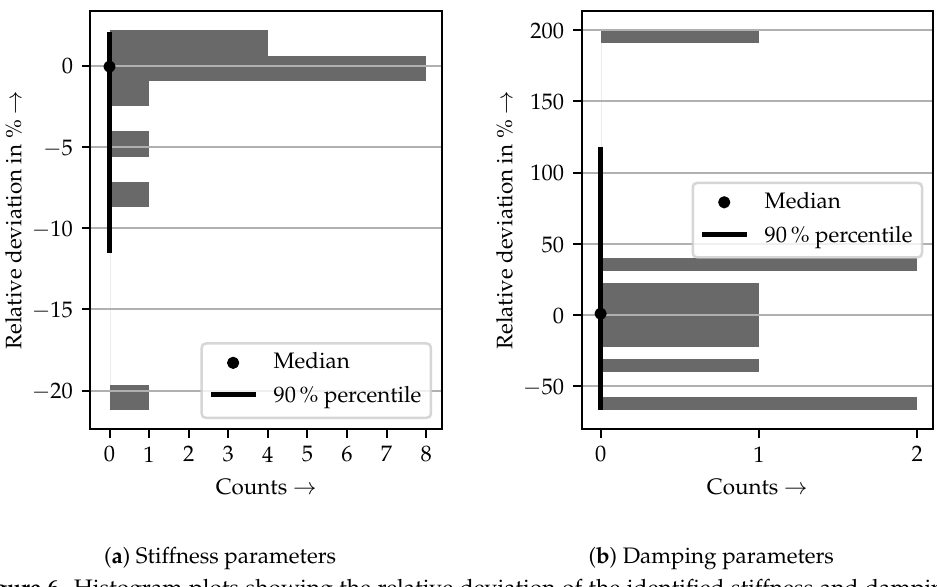
Figure 6. Histogram plots showing the relative deviation of the identified stiffness and damping parameters from their true known value for the case “ideal model vs. simulated data”; additionally, their median value and 90% percentiles are